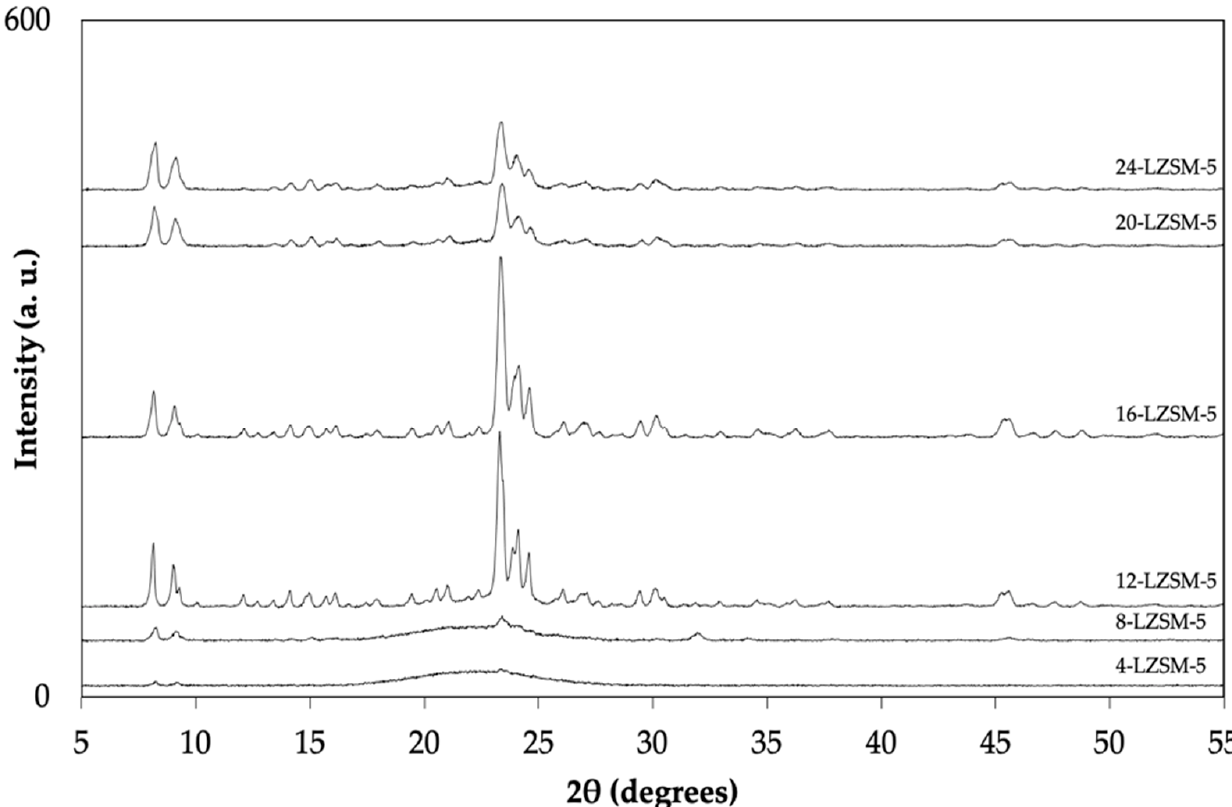
Figure 2. XRD patterns of the ZSM-5 synthesized using lignin.